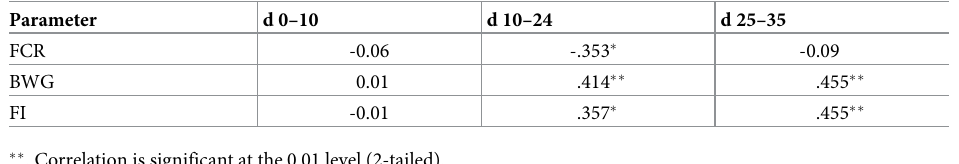
Table 1. Correlations between the independent variables and the covariate male % for each phase for Experiment 1.